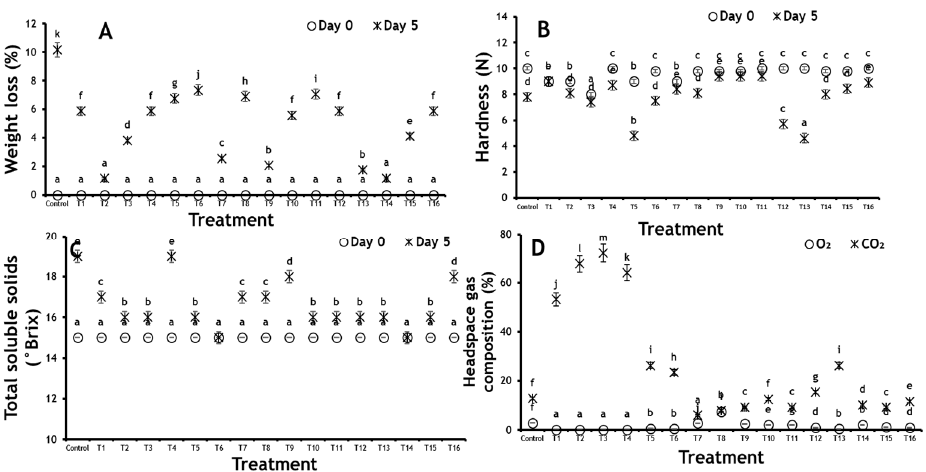
Figure 2. Quality analysis and gas composition of minimally processed pomegranate arils stored under active MAP at ambient temperature. Weight loss ( A ), hardness ( B ), total soluble solids ( C ), and headspace gas composition ( D ). Error bar represents the standard deviation from the mean of three independent replicates. In Figure 2D, headspace gas composition was reported on day 5. The mean values followed by lowercase letters (a–m) among the treatments (T1–T16 and control) were significantly different ( p < 0.05) on the basis of Duncan’s multiple range test. MAP = modified atmosphere packaging. For treatment codes, refer to Table 1.